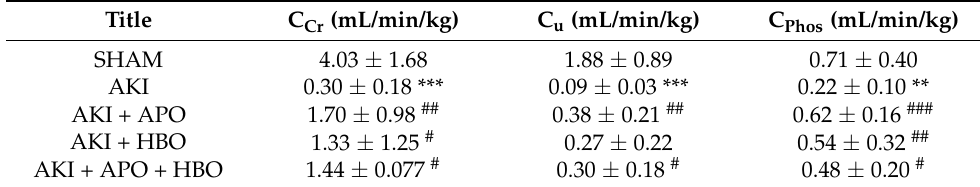
Table 1. Creatinine (C Cr ), urea (C U ) and phosphate (C Phos ) clearances 24 h after